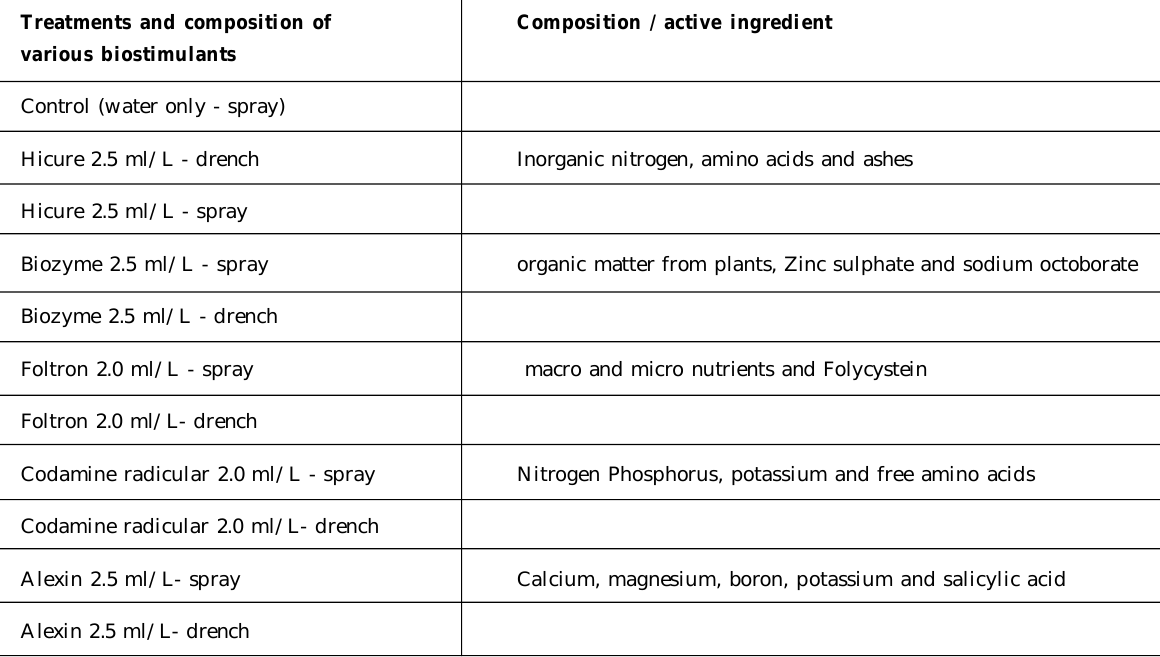
Table 1: Various biostimulant treatments and their composition Treatments and composition